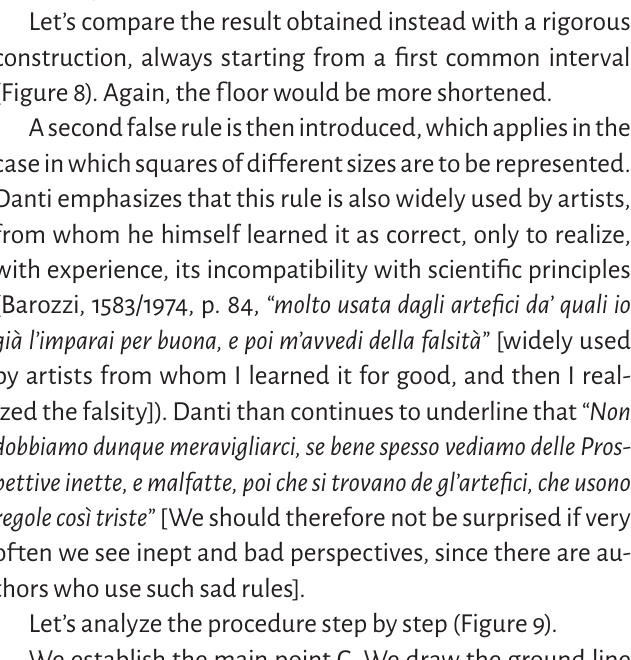
Figure 8 Comparison with the perspective construction of the same subject of figure 7 conducted in a rigorous way. Author’s